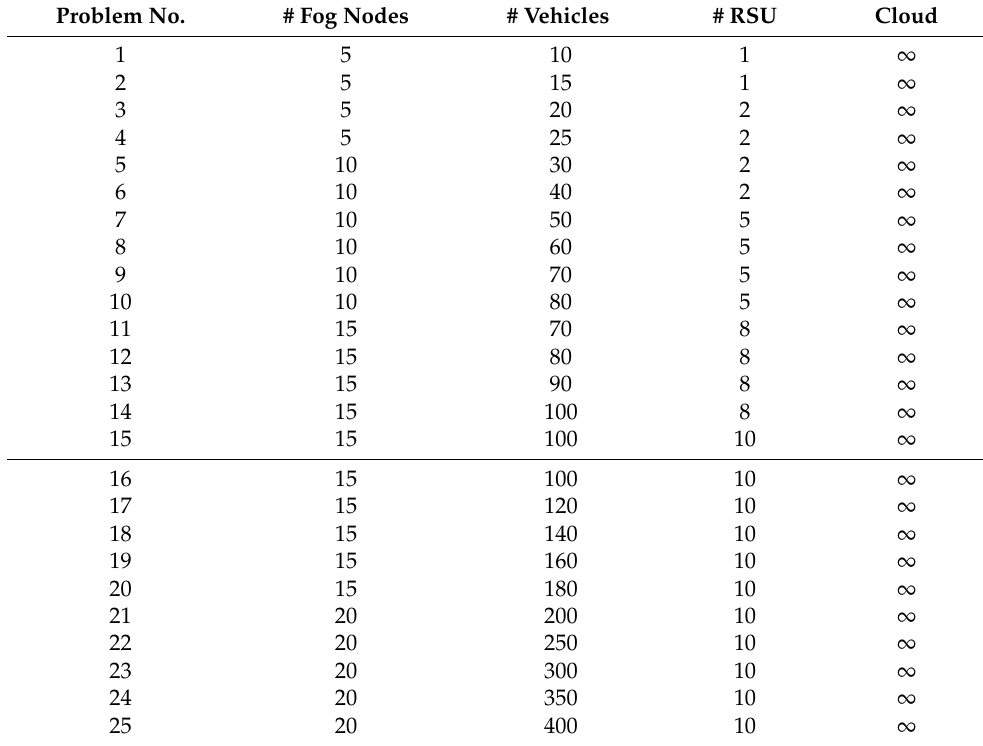
Table 5. Problem instances for SONG experiments. Problem